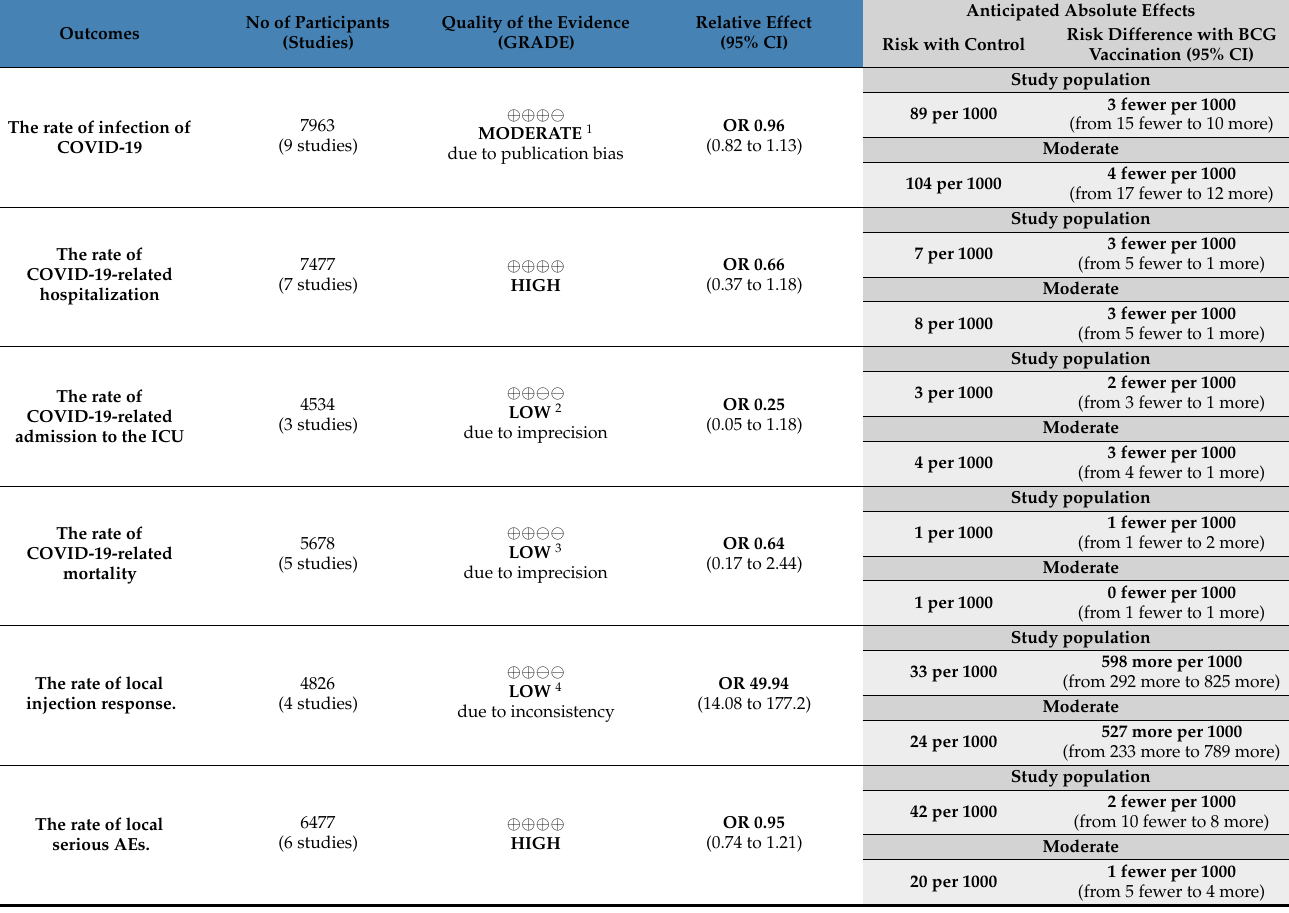
Table 2. GRADE assessment on the quality of the